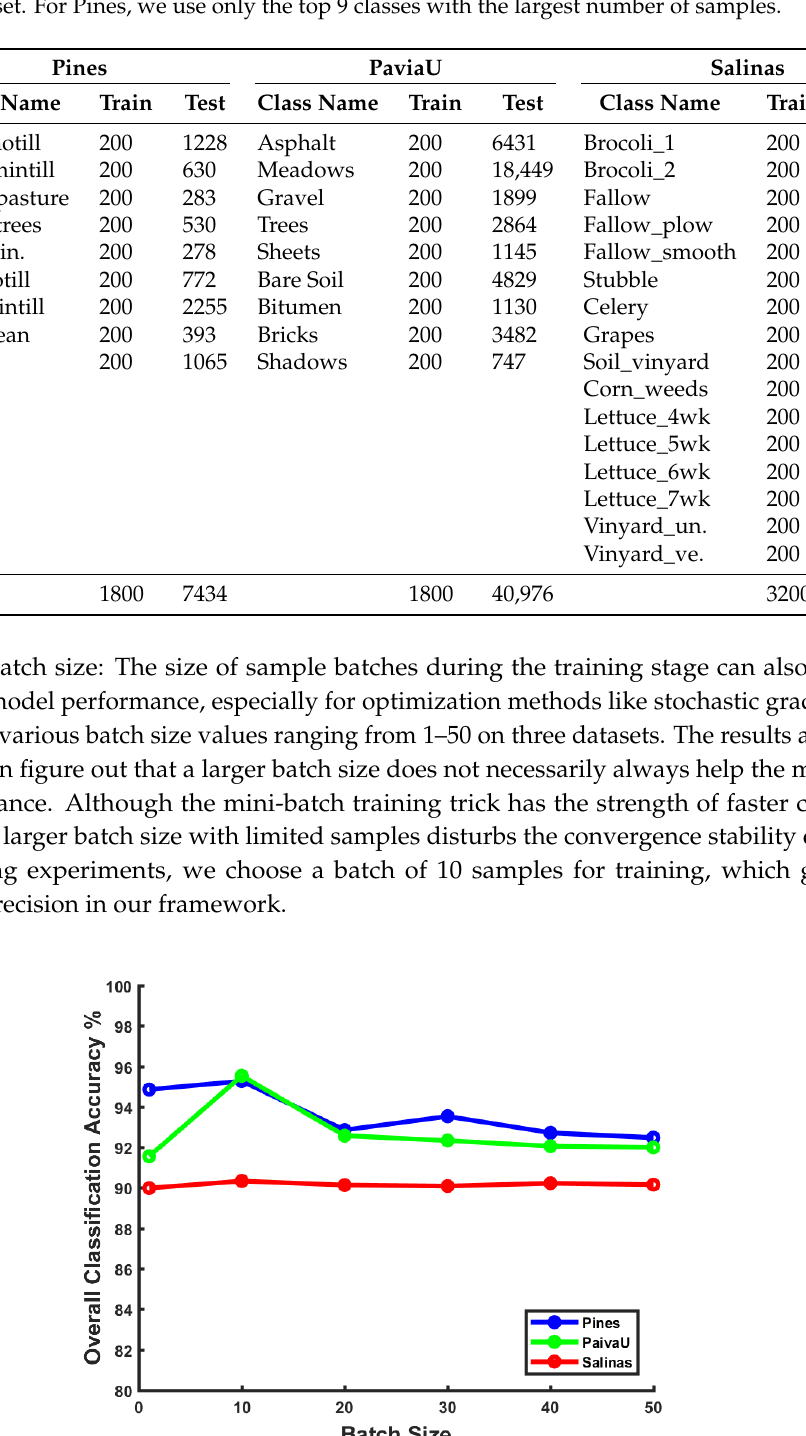
Table 2. Detailed configuration of the three datasets (Pines, University of Pavia (PaviaU) and Salinas) used in this paper. For each class, 200 samples are randomly selected as the training set and the rest as the testing set. For Pines, we use only the top 9 classes with the largest number of samples.